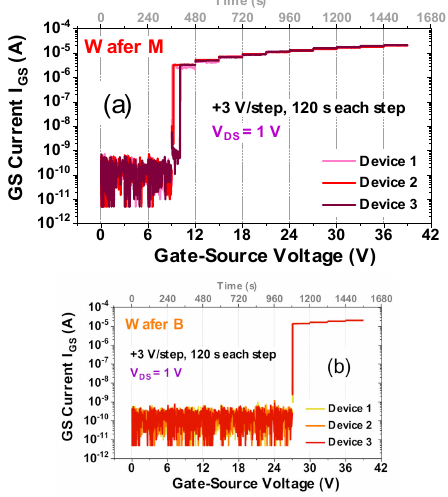
Figure 9. Forward gate-source step stress at V DS = 1 V. ( a , b ) present typical stress current (I GS ) characteristics for three Wafer M (uni-layer) devices ( a ) and three Wafer B (bilayer) devices ( b ).